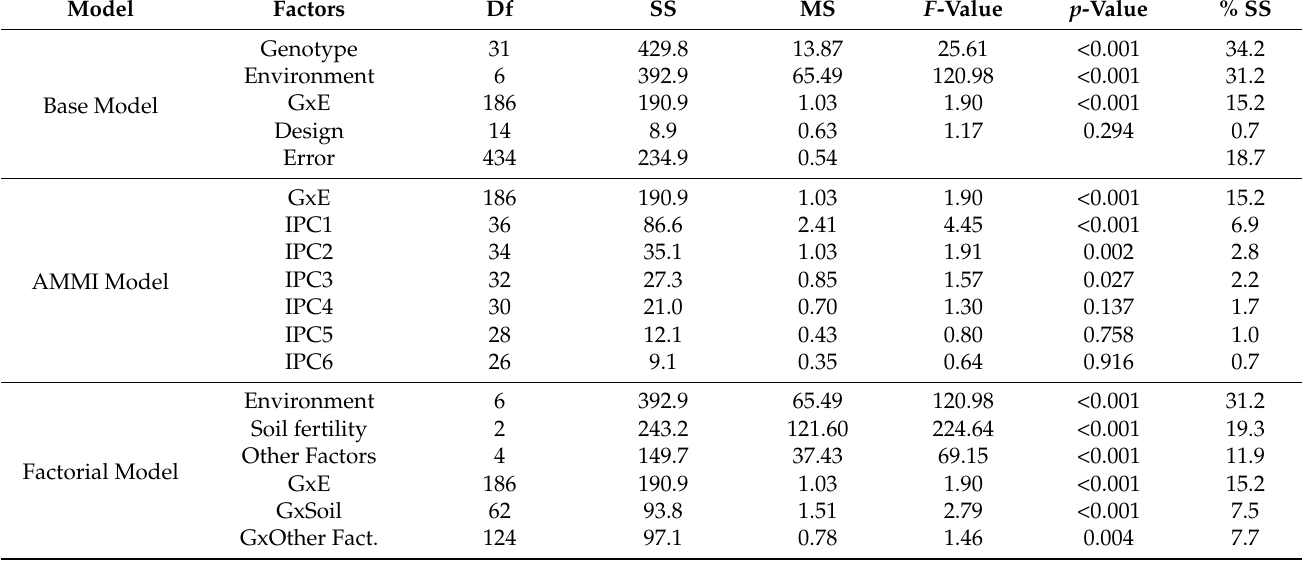
Table 2. Analysis of variance for yield using the base model the additive main effect and multiplicative interaction (AMMI) model and the factorial model. With degrees of freedom (Df), sums of squares (SS), mean square (MS), the F-value, p -value and the proportion of SS associated with each factor over the total SS